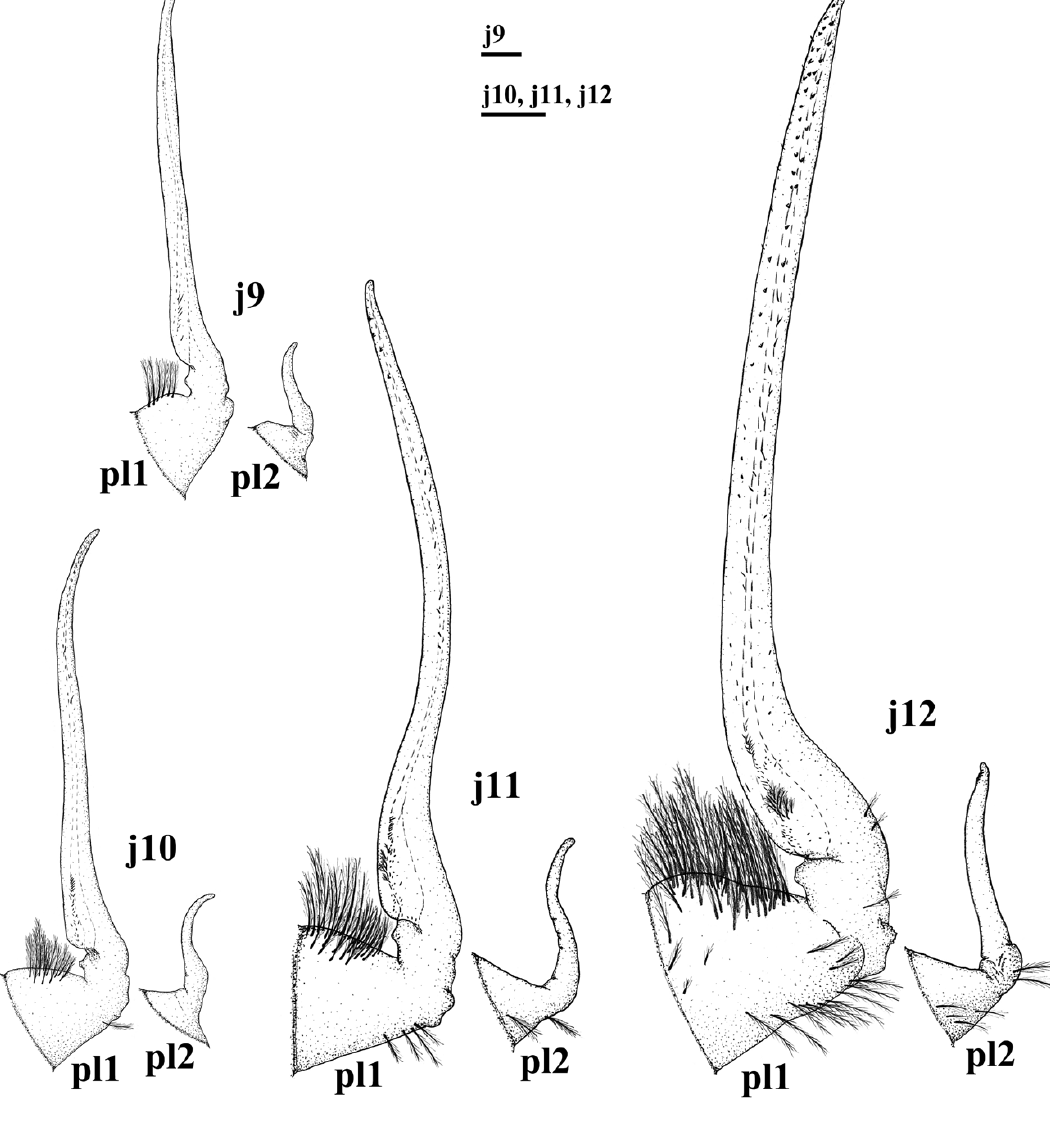
Figure 7 - Callinectes danae . pl1 and pl2 : pleopods of the 1 st and 2 nd male abdominal somites, respectively, from 9 th ( j9 ), 10 th ( j10 ), 11 th ( j11 ) and 12 th (j12) stages on. Scale: j9 , 0.2mm; j10 , j11 and j12 ,